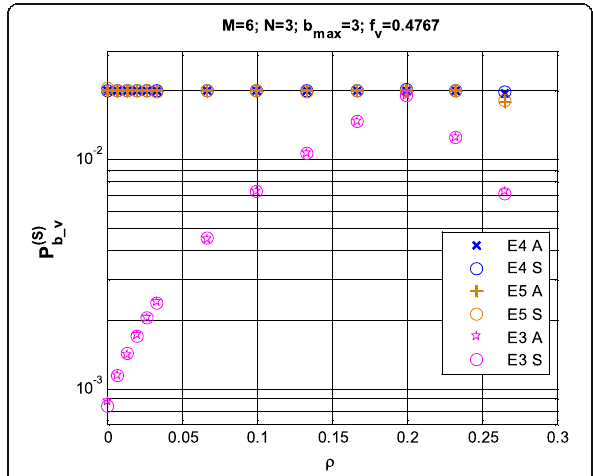
Fig. 9 New call blocking probability of secondary voice users for the corresponding optimal configuration of each strategy as function of the primary channel utilization